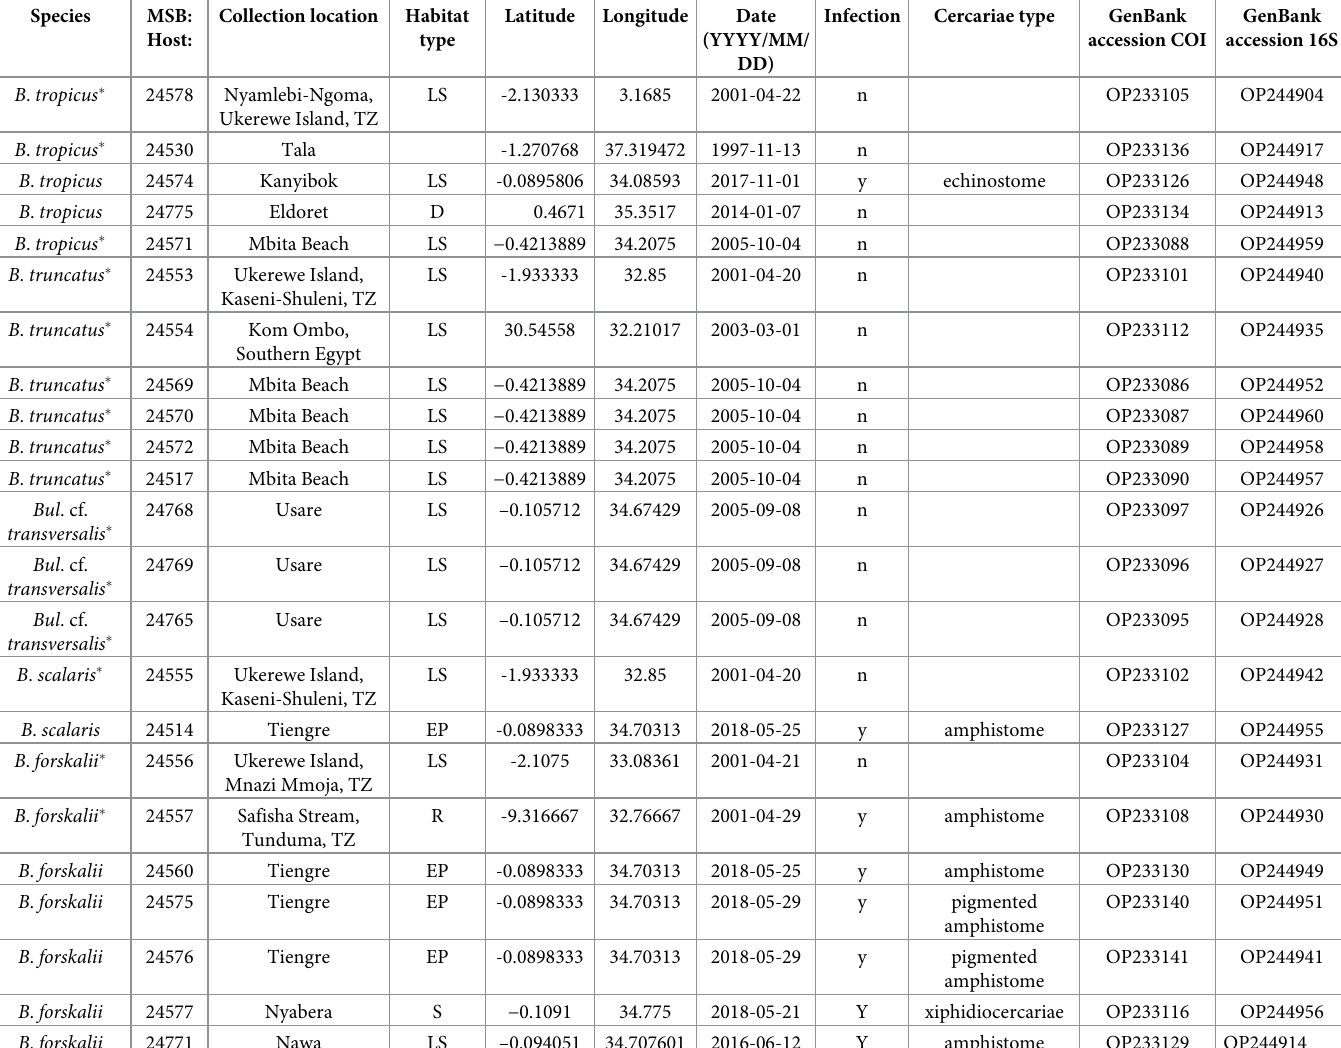
Table 1. Sequenced specimens with associated MSB:Host: numbers, collection locations, habitat type, GPS coordinates (when available), infection status, and associated GenBank accession numbers. Specimen names denoted with � indicate samples from archived specimens. Bulinus productus specimens are often designated as Bulinus nasutus productus in literature regarding this region. Habitat type abbreviations: LS = lakeshore, L = lake, R = river, EP = ephemeral pond, P = pond, D = Dam, S = Swamp. Samples were collected in Kenya unless otherwise